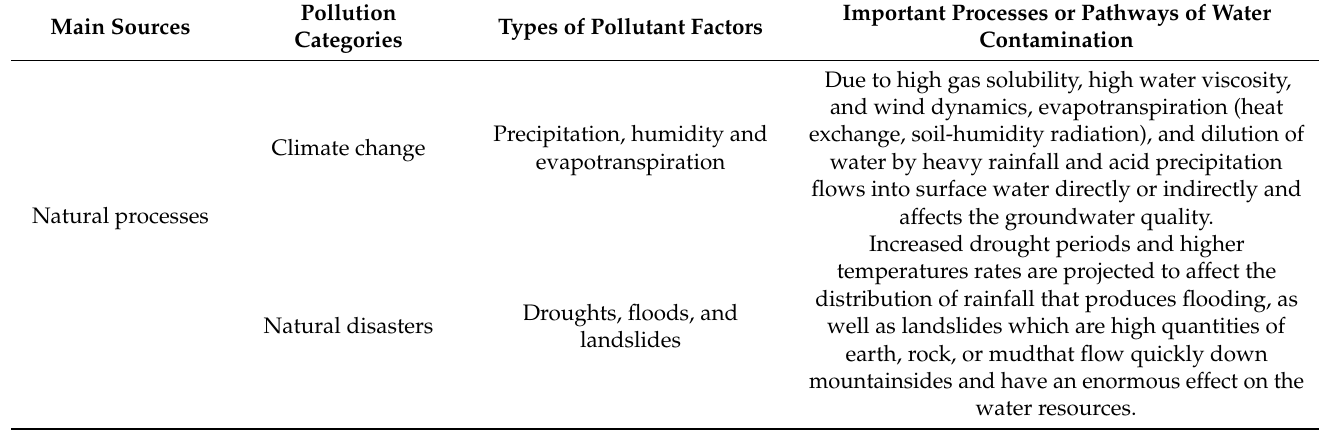
Table 1. The major causes of pollution, contaminant types, and their important processes. Main